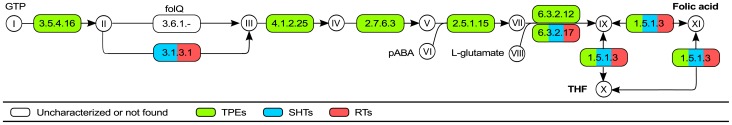
Biosynthesis of folic acid.
Metabolites - I: Guanosine 5'-triphosphate; II: 7,8-Dihydroneopterin 3'-triphosphate; III: Dihydroneopterin; IV: 2-Amino-4-hydroxy-6-hydroxymethyl-7,8-dihydropteridine; V: 2-Amino-7,8-dihydro-4-hydroxy-6-(diphosphooxymethyl)pteridine; VI: para-aminobenzoate; VII: Dihydropteroate; VIII: L-glutamate; IX: Dihydrofolate; X: Tetrahydrofolate; XI: Folic acid. Enzymes -
3.5.4.16: GTP cyclohydrolase I; 3.1.3.1: alkaline phosphatase; 3.6.1.-: Hydrolase acting on acid anhydrides in phosphorus-containing anhydrides; 4.2.1.25: dihydroneopterin aldolase; 2.7.6.3: 2-amino-4-hydroxy-6-hydroxymethyldihydropteridine diphosphokinase; 2.5.1.15: dihydropteroate synthase; 6.3.2.12: dihydrofolate synthase; 6.3.2.17: folylpolyglutamate synthase; 1.5.1.3: dihydrofolate reductase.